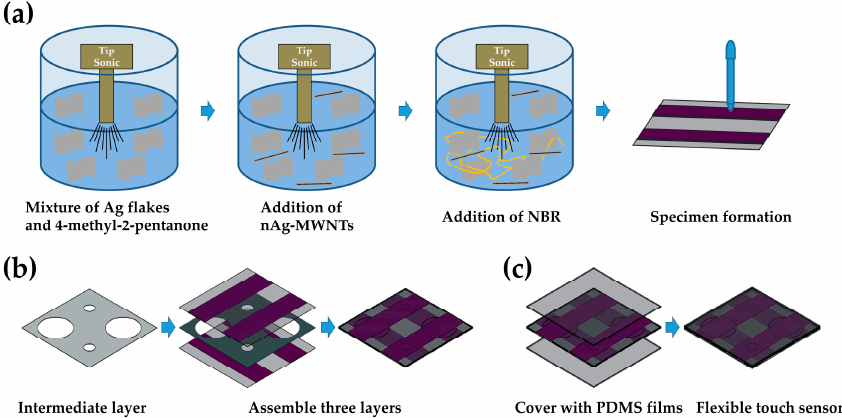
Figure 2. ( a ) Patterning the electrode with CFAs; ( b ) Assemble electrode layers; ( c ) Sealing with PDMS.